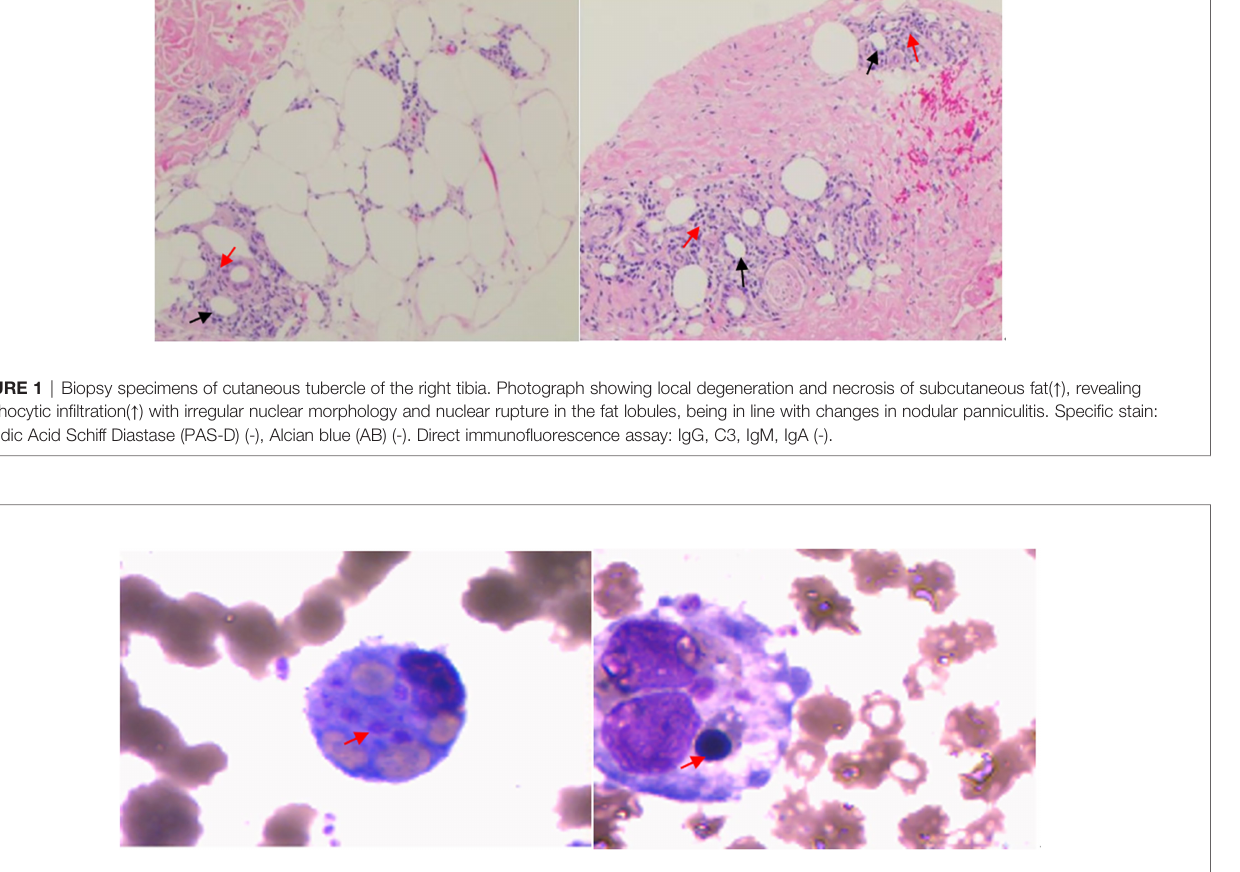
FIGURE 2 | Bone marrow smears showing hematopoietic cells ( ↑ ) and increased